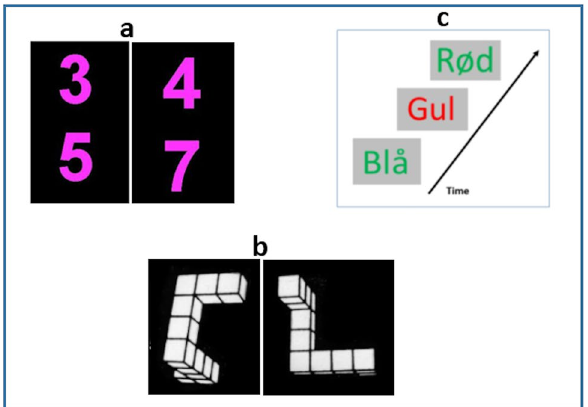
Figure 4. Examples of the stimuli used in the three cognitive tasks. ( a ) Shows examples of the digit pairs shown on each trial: The left part of the example shows two digits that do not match the target since the sum of the two is < 11. To the right are shown two numbers that match the target since the sum is 11, and the subject should then correspondingly press the response button. ( b ) Shows two of the 3D objects that should be compared for similarity: The example shows two object shapes that are the same but rotated horizontally with regard to each other. The subject should press the response button in this example if the shape is the same. ( c ) Shows an example of the 2-back Stroop working memory task in Norwegian, where the instruction is to press the button when the colour of the word matches with the colour shown two items